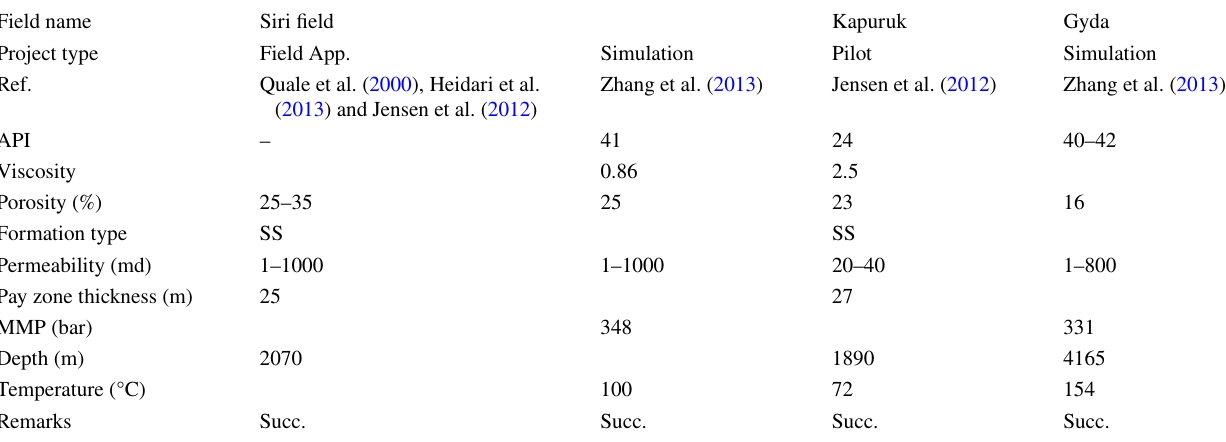
Table 5 Reservoir data for SWAG field projects as well as some important